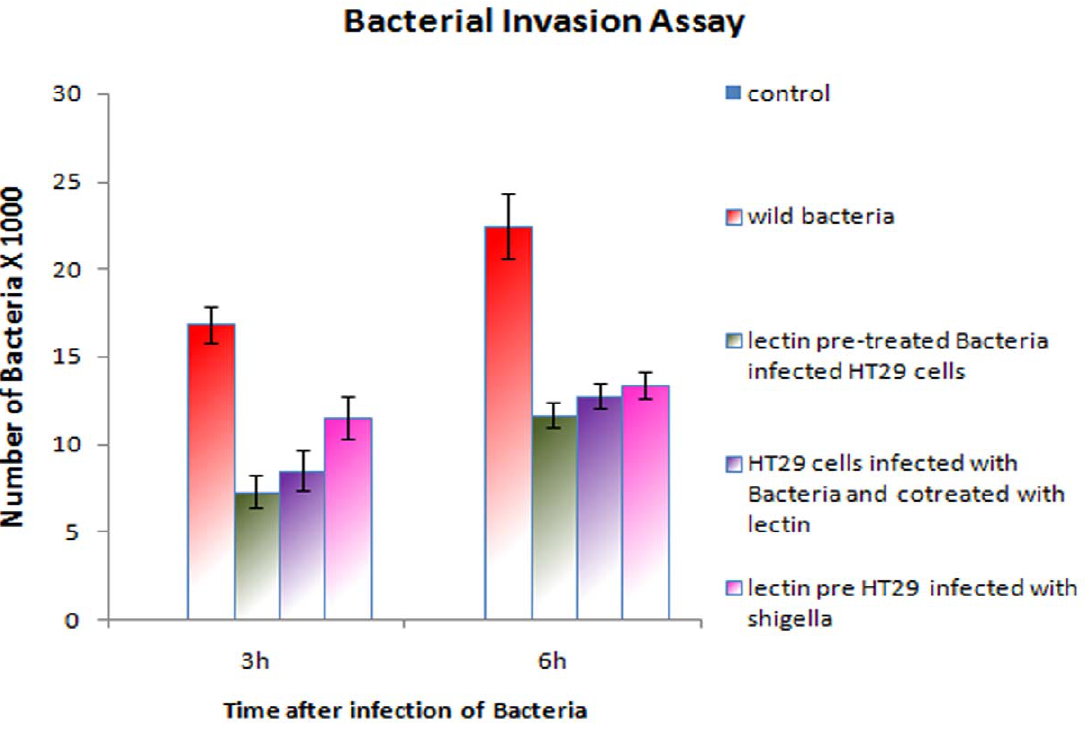
Figure 8. Bacterial Invasion Assay. Invasion of Shigella dysenteriae to HT29 cells was significantly decreased in presence of lectin when compared invasion of Shigella dysenteriae to HT29 cells in absence of lectin. p . 0.001 is considered as highly significant. p Value mentioned in the above graph is compared with invasion of Shigella dysenteriae to HT29 cells in absence of lectin.